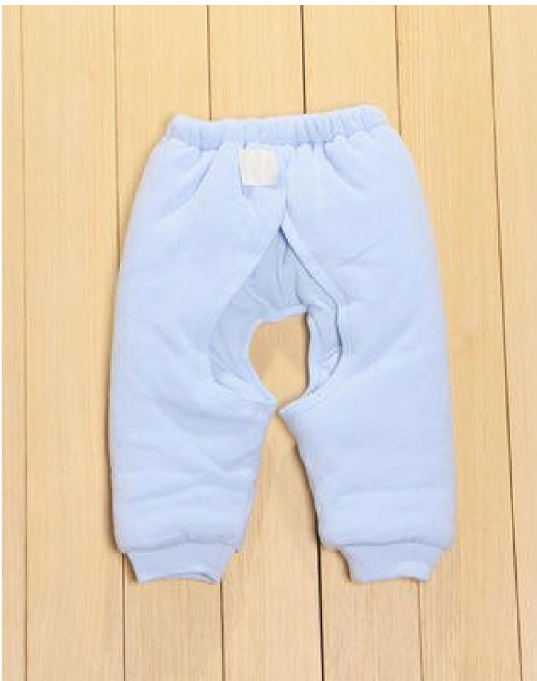
Figure 1. With split-crotch pants, it is more convenient for parents to wean off diapers in a timely manner and to allow the children to control their own urination and defecation. (Photo taken and provided by the first author and the